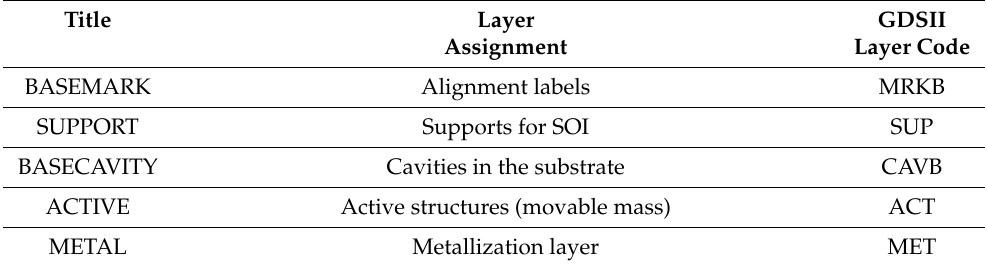
Table 8. List of topological layers of the manufacturing process.